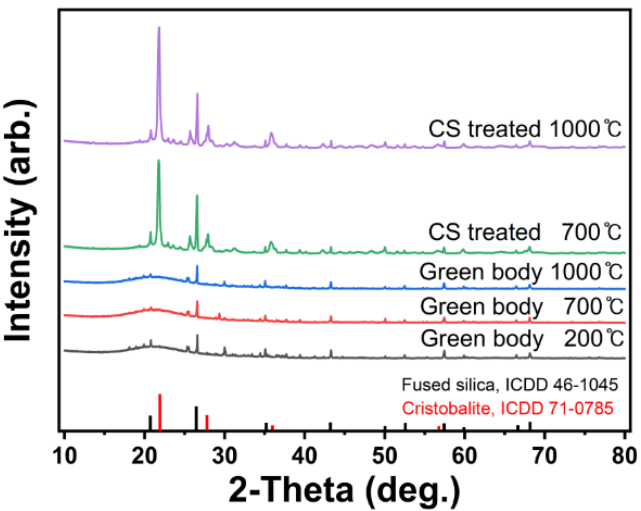
Figure 5. Confirmation of XRD peaks of samples after molding of powder bed 3D printed article and after heat treatment at 200, 700, and 1000 °C after treatment with colloidal silica.